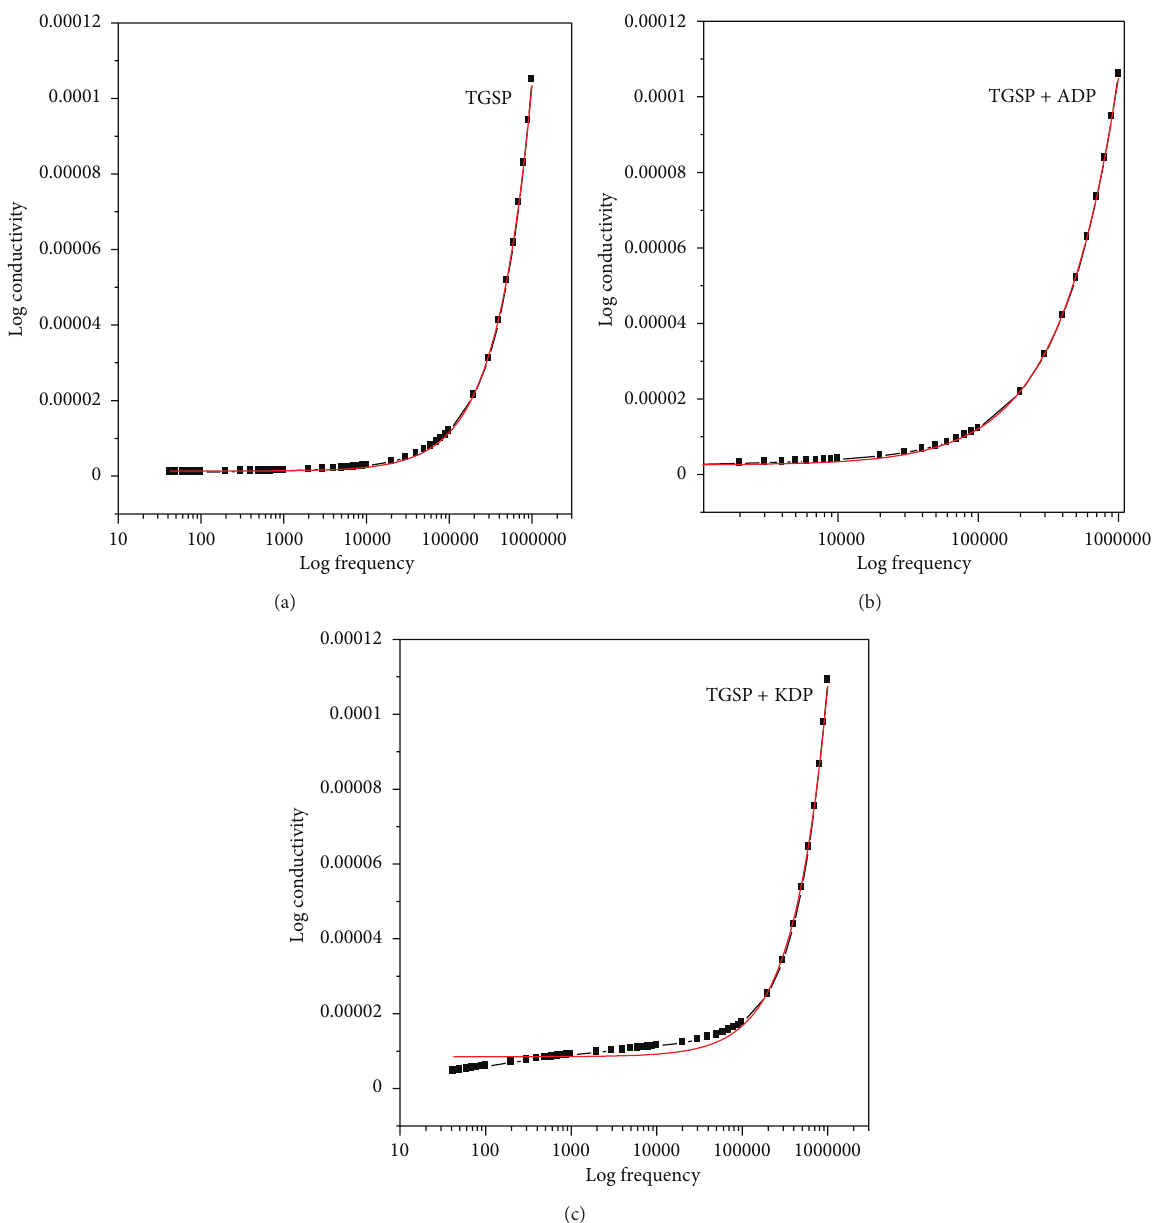
Figure 8: Frequency versus conductivity graphs of (a) TGSP, (b) TGSP + ADP, and (c) TGSP + KDP crystals. regions: frequency-independent Ac conductivity region in low-frequency range and frequency-dependent dc conduc- tivity region in high-frequency range. Conductivity graphs obey Arrhenius’ relation and Jonscher’s power law